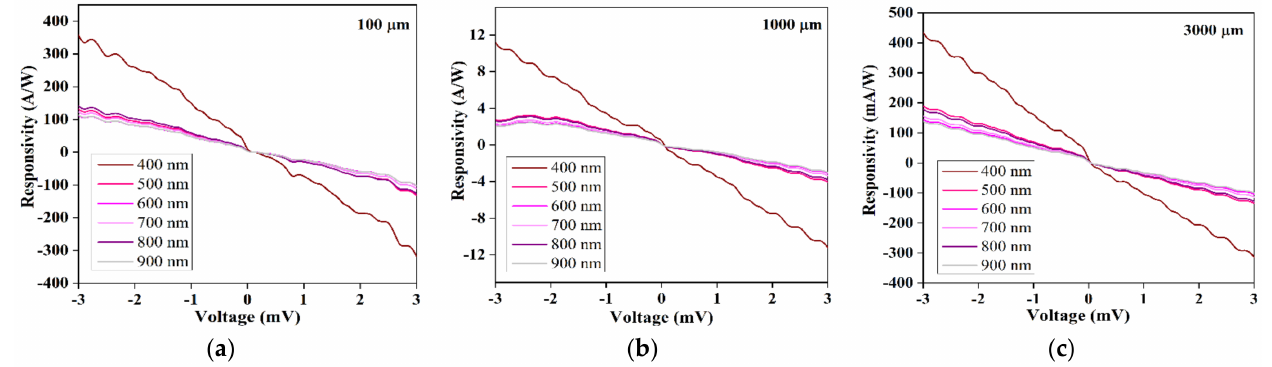
Figure 8. Responsivity, R λ (V), of graphene/IDE devices as a function of the wavelength (400 to 900 nm). ( a ) 100 µ m; ( b ) 1000 µ m; and ( c ) 3000 µ m.